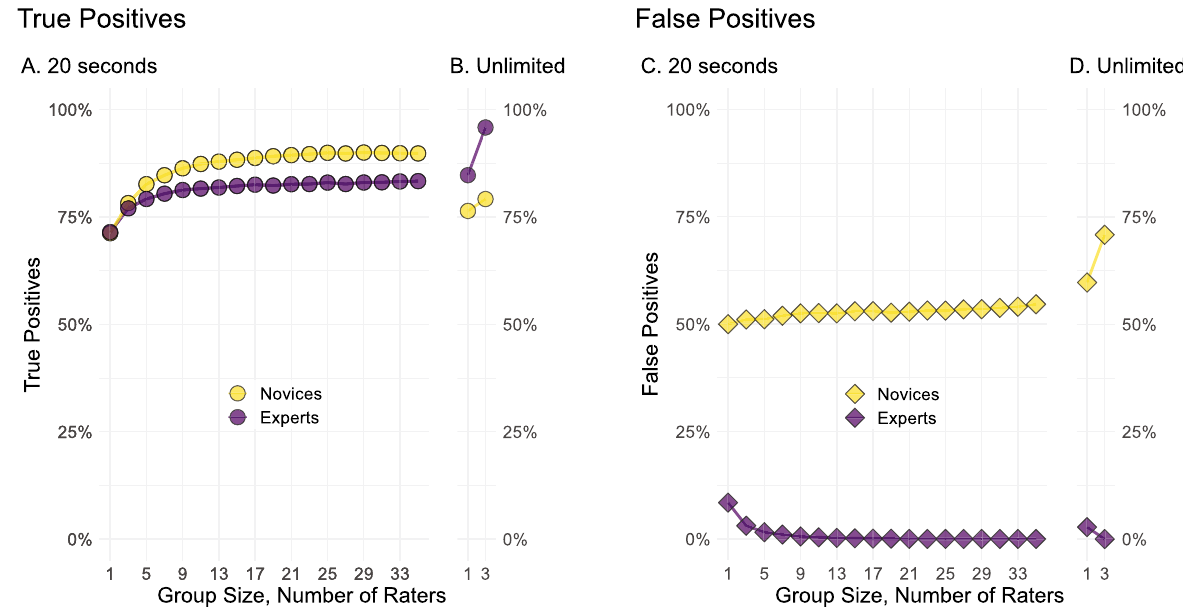
Fig. 2 Mean true-positive rates for groups of novices and experts after 20 s of analysis ( a ) or without a time limit ( b ), and mean false positive rates for groups of novices and experts after 20 s of analysis ( c ) or without a time limit ( d